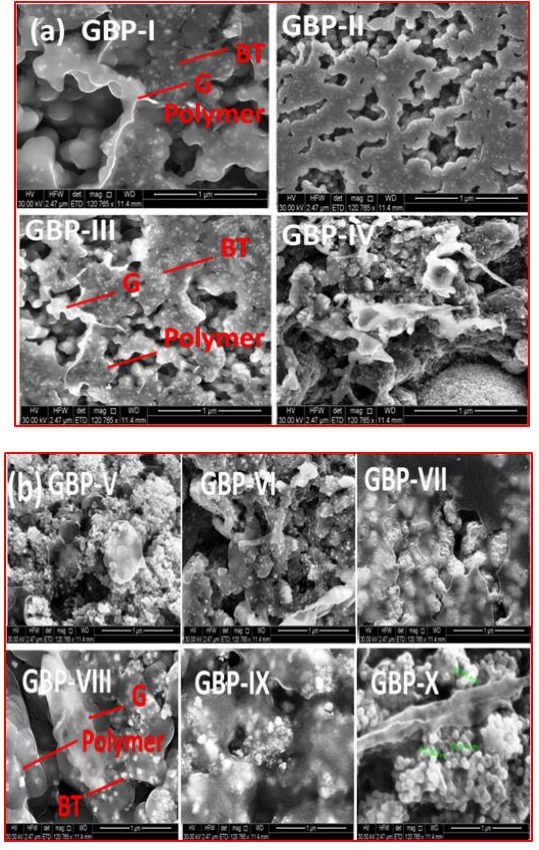
Figure 2. Field emission scanning electron microscopy (FESEM) images of ( a ) G/BT/PVDF nanocomposite films with different graphene fraction and ( b ) G/BT/PVDF nanocomposite films with different barium titanate (BT)